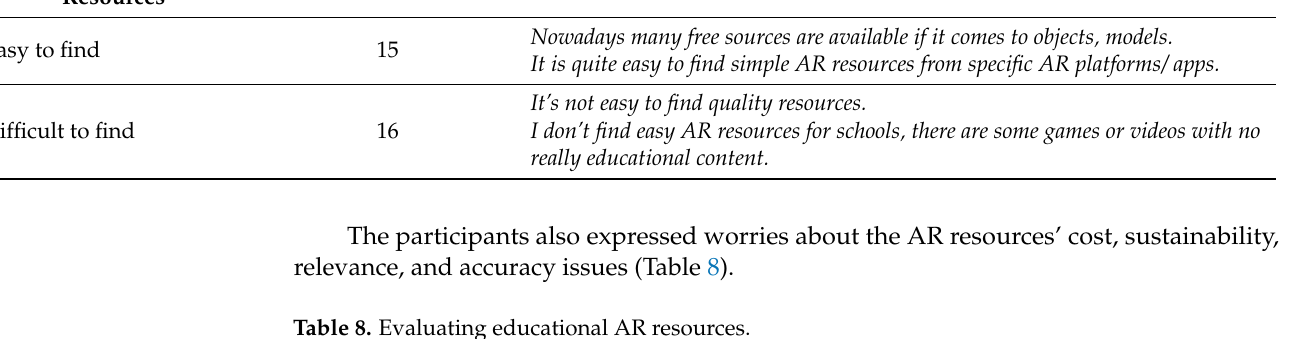
Table 8. Evaluating educational AR